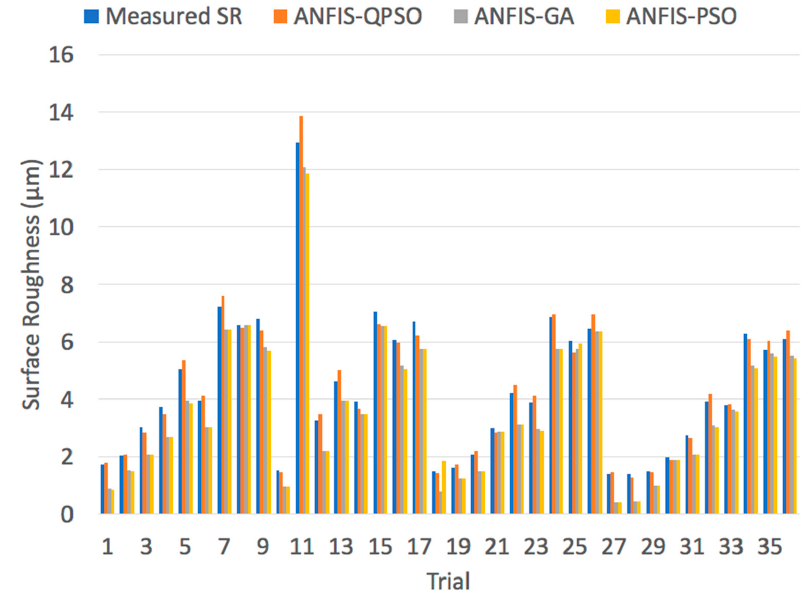
Figure 16. Measured surface roughness vs. predicted surface roughness values of a cryogenic turning